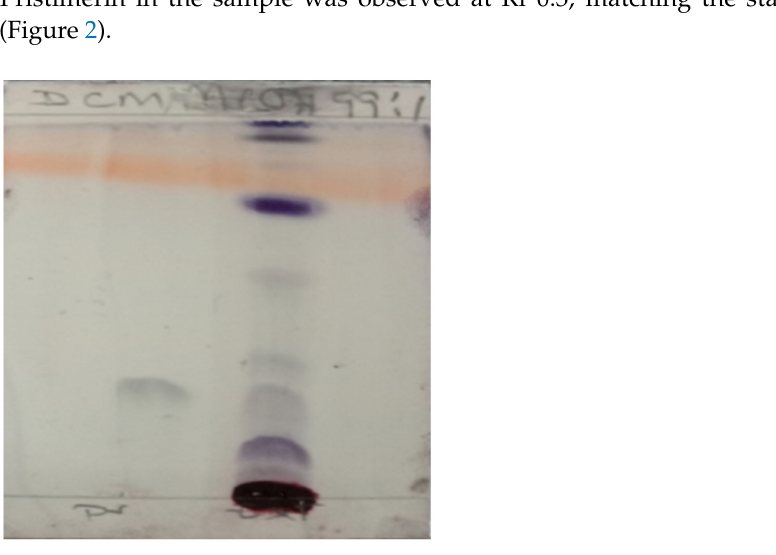
Figure 2. Thin layer chromatography (TLC) shows the presence of an active ingredient (Pristimerin).